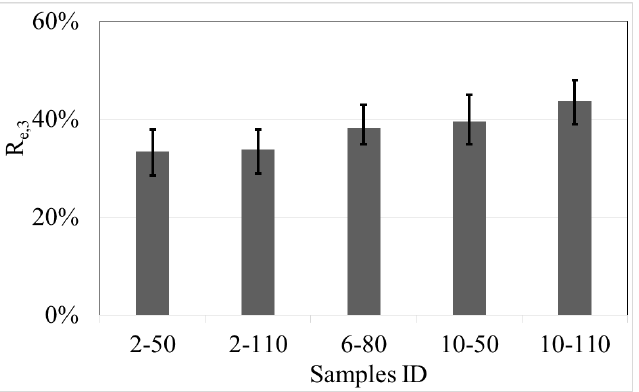
Figure 17. Equivalent flexural strength ratio of concrete with recycled PET fibres.